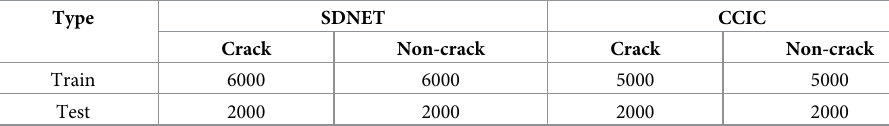
Table 1. Number of different samples in the WCD dataset.